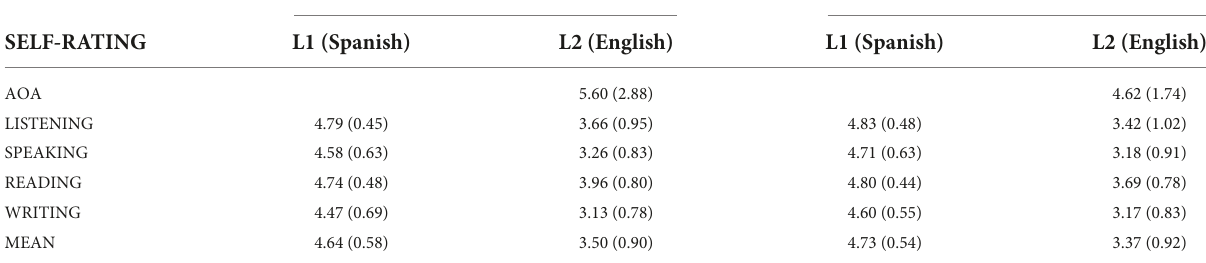
TABLE 1 Characteristics of